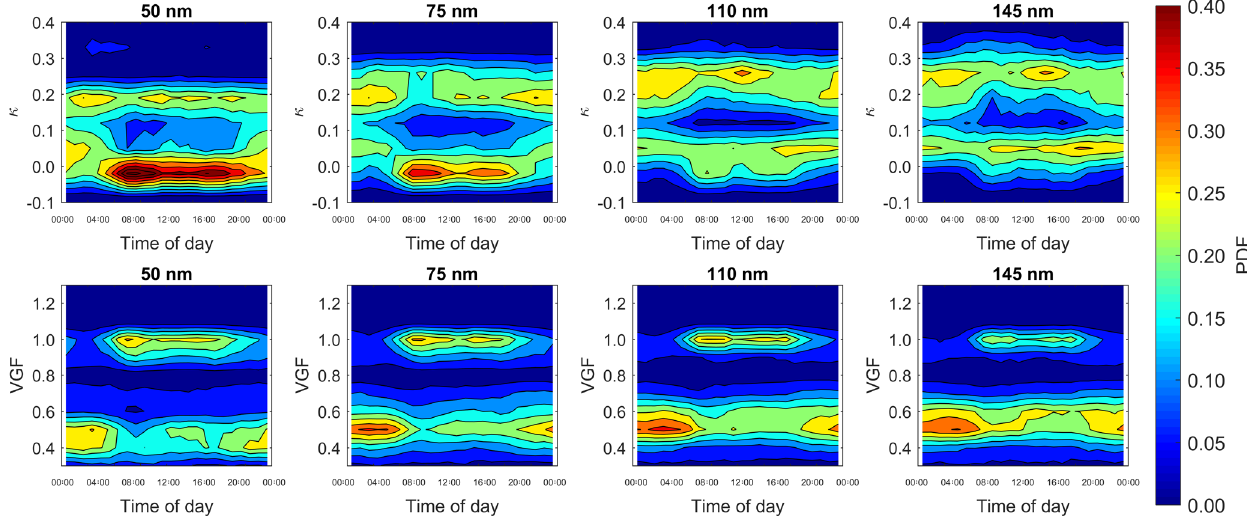
Figure 8. Mean diurnal variation of the hygroscopicity parameter κ and volatility growth factor (VGF) probability distribution function (PDF) for particles with different dry diameters. The negative κ values are an artefact of plotting the